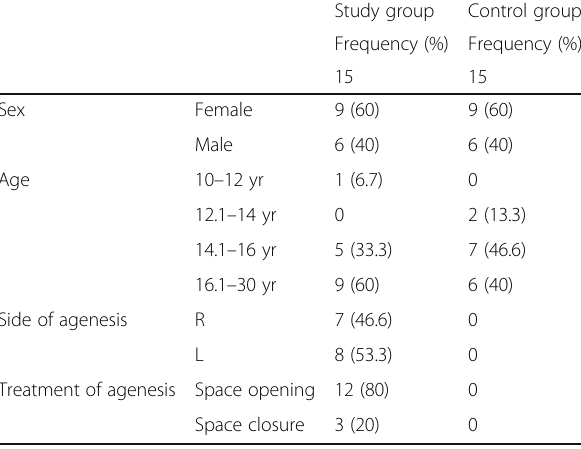
Table 1 Descriptive patient characteristics for study and control